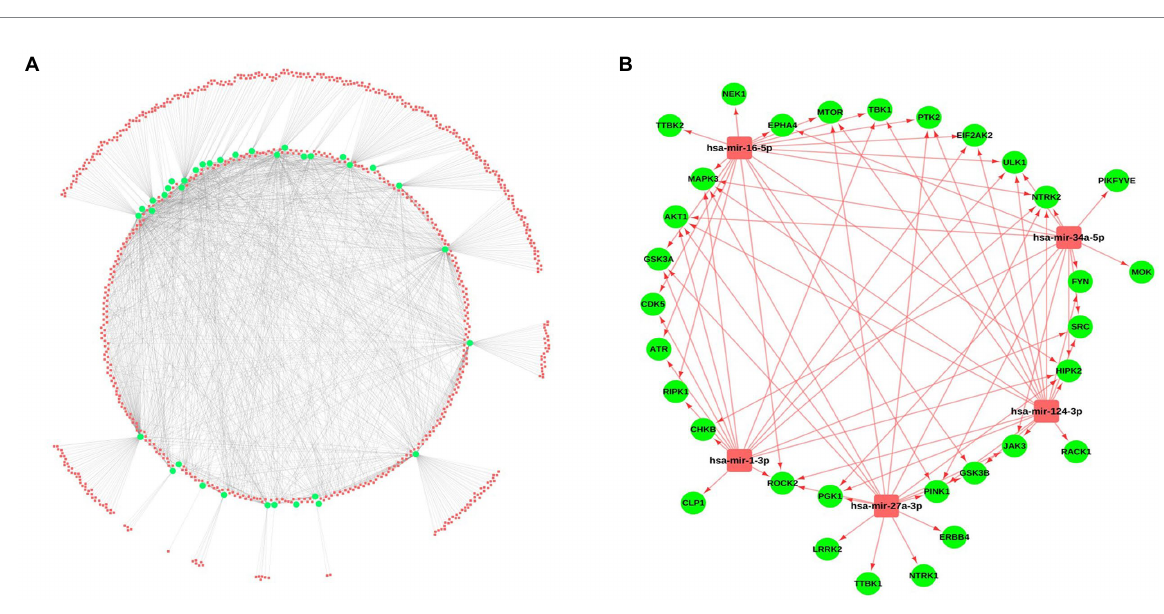
focal adhesion-PI3K-Akt–mTOR-signaling pathway (Figure 5; Supplementary Table S6).